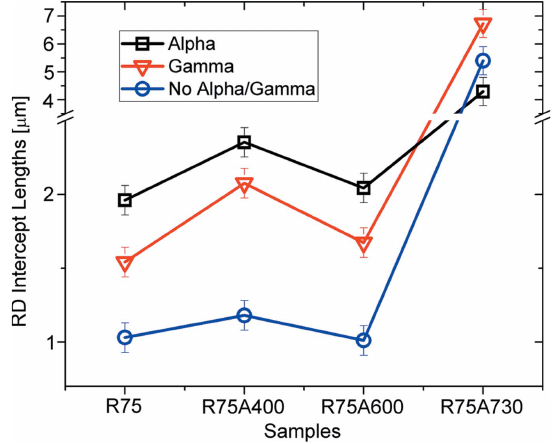
Figure 20 Average intercept lengths along the RD direction, for each partition and sample, further confirm the trend observed in Fig. 19.